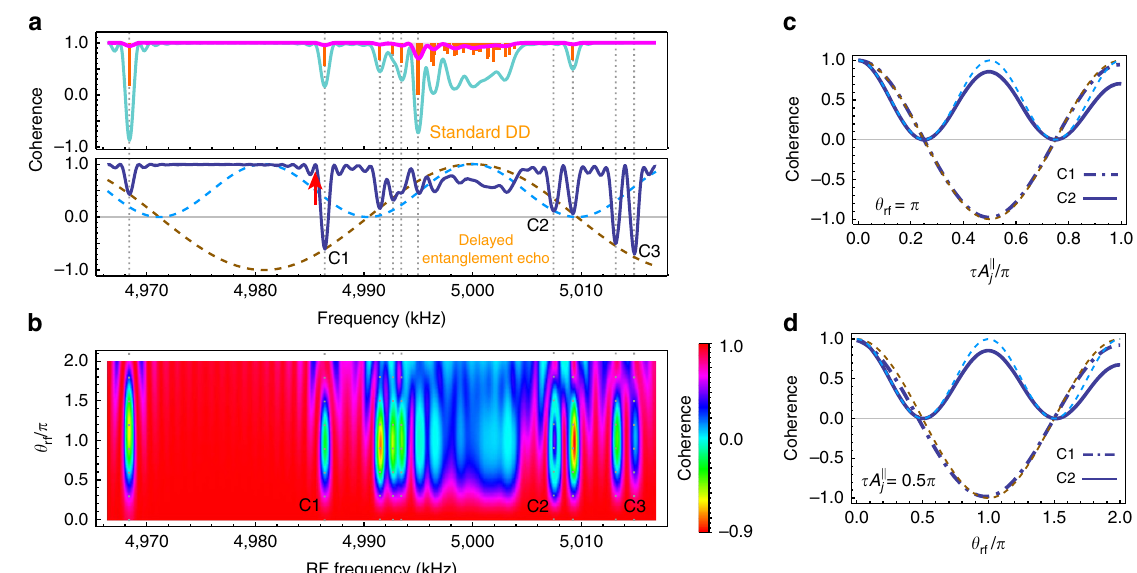
Figure 2 | Coherence signals of delayed entanglement echo. ( a ) Comparison between the delayed entanglement echo and standard DD method on the coherence dips of NV electron qubit by using the electron spin levels m s ¼ 0 and þ 1. The magenta (turquoise) solid line shows the population signal of standard DD method by 100-pulse (400-pulse) CP sequences as a function of the frequency k DD /(2 t CP ), where the harmonic branches k DD ¼ 25 (99) are chosen for a sequence duration of E 1ms. The blue solid line shows the signal of delayed entanglement echo with the interaction time t ¼ 13 m s, and the RF driving for the single-spin rotation angle y rf ¼ p is protected by 100-pulse CP sequences to achieve a duration of E 1ms. The dashed lines show the expected height of the signal dips L p ( o rf — o 13 y rf ) for the delayed entanglement echo (see equation (3)) when there are one ( p ¼ 1, brown) or two ( p ¼ 2, C, , and the vertical dotted lines show the cyan) spins at the corresponding spectral position. The lengths of the vertical orange lines are proportional to A ? j precession frequencies o j (bare Larmor frequency o 13 ¼ 2 p (cid:10) 5MHz). ( b ) Signal of delayed entanglement echo as in a but changing y rf and transferring C the NV electron qubit to the levels m s ¼ ± 1 for the interaction windows. ( c , d ) Coherence oscillations when changing t and y rf using the scheme in b .